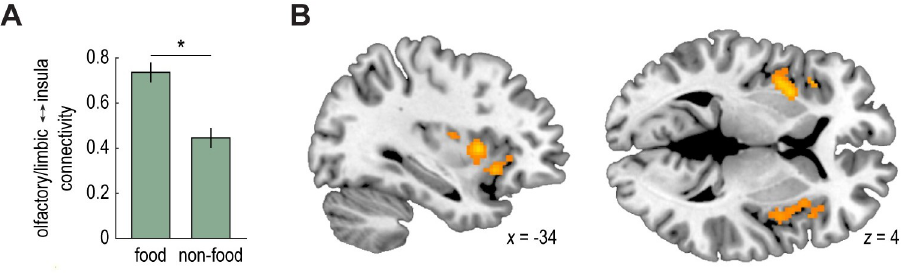
Fig 6. Functional connectivity in response to food versus nonfood odors. Enhanced functional connectivity between an olfactory/limbic seed region and insula during food vs. nonfood odor trials. This finding was based on the functionally defined ROI in right insula (t (29) = 2.73, p = 0.01; A), and regional specificity was further confirmed by a voxel-wise test using anatomically defined ROIs in left and right insula (left insula: x = − 34, y = 8, z = 4, t (29) =